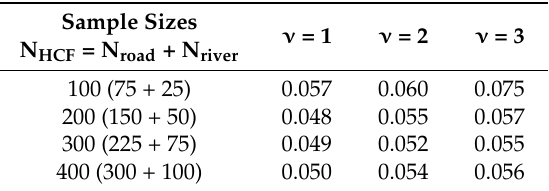
Table 1. Estimated type I error probabilities. HCF: Human caused